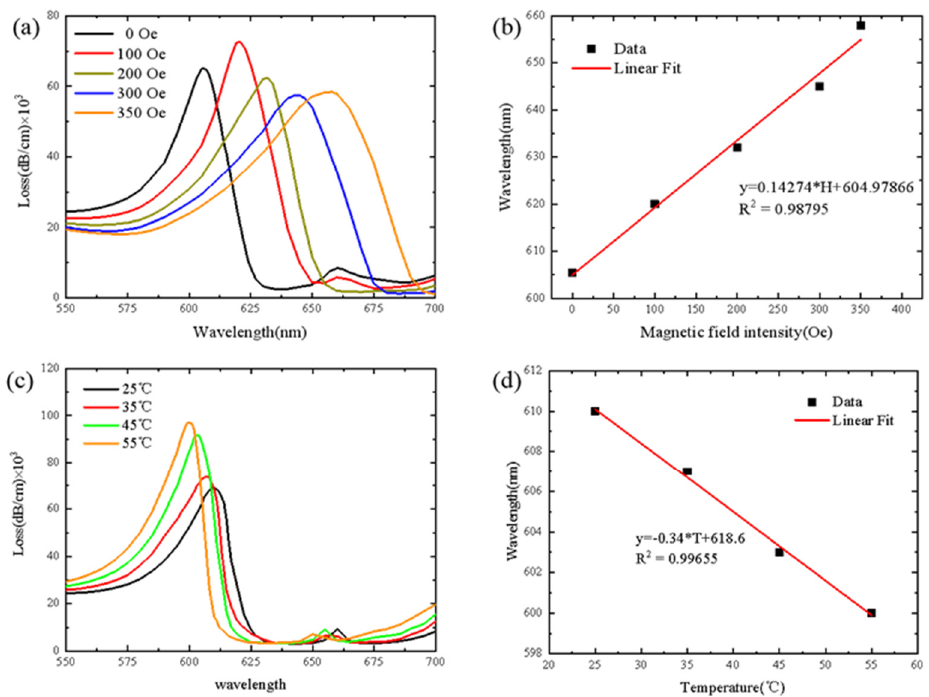
Figure 5. ( a ) Loss spectra of Channel 2 under different magnetic field strength (temperature is fixed as 25 ◦ C). ( b ) Fitting results of resonance wavelength at different magnetic field strength. ( c ) Loss spectra of Channel 2 under different temperatures (magnetic field is fixed as 0 Oe). ( d ) Fitting results of resonance wavelength at different temperatures.